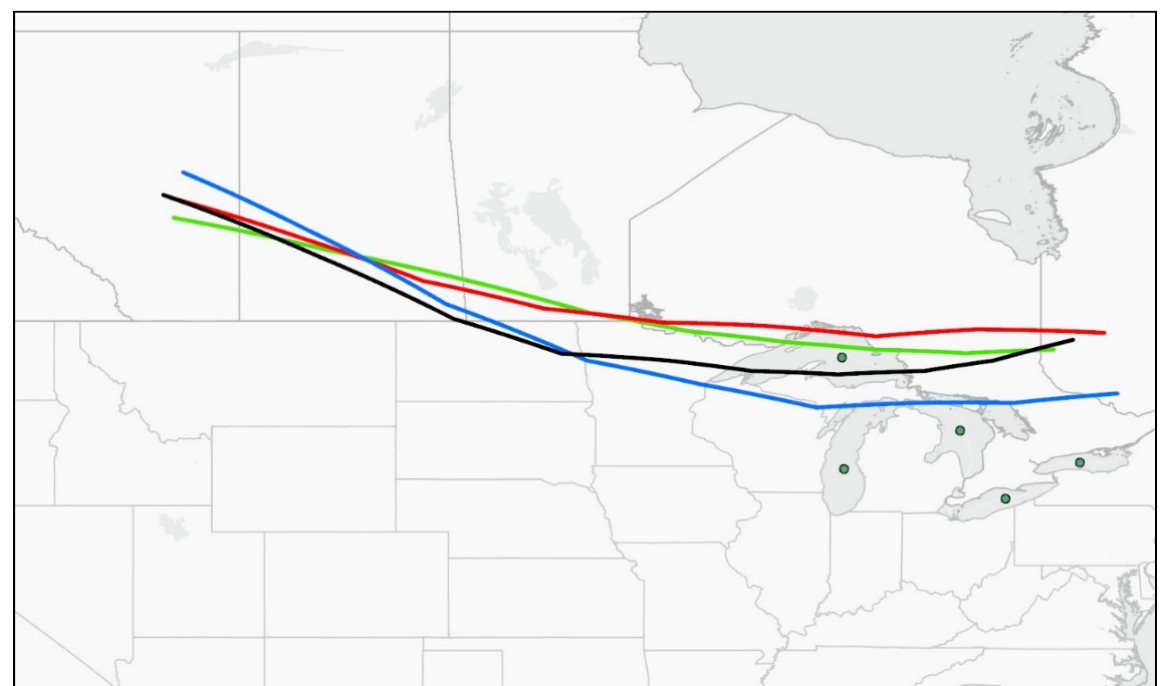
Figure 5. Composite tracks of Cluster 1 (green line), Cluster 2 (red line), Cluster 3 (blue line), and LES associated (black line) clippers from t = 0 h (time of departure) to t = 54 h. Outlined dark green dots represent the NARR grid points used to calculate low-level lapse rates.